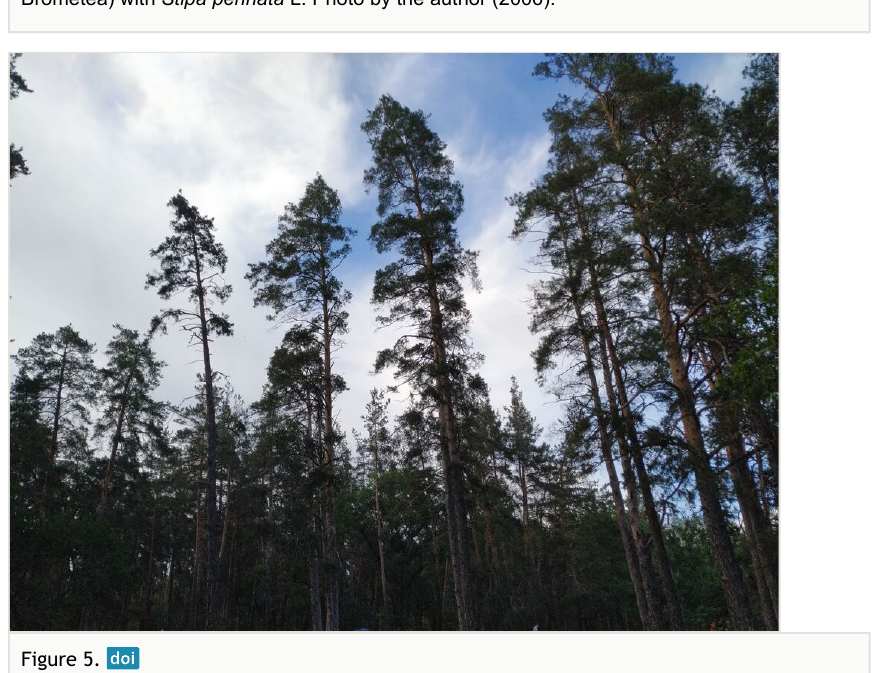
Typical plant communities of the Polibino local flora (Lipetsk Oblast, Russia): steppe (Festuco- Brometea) with Stipa pennata L. Photo by the author (2006).